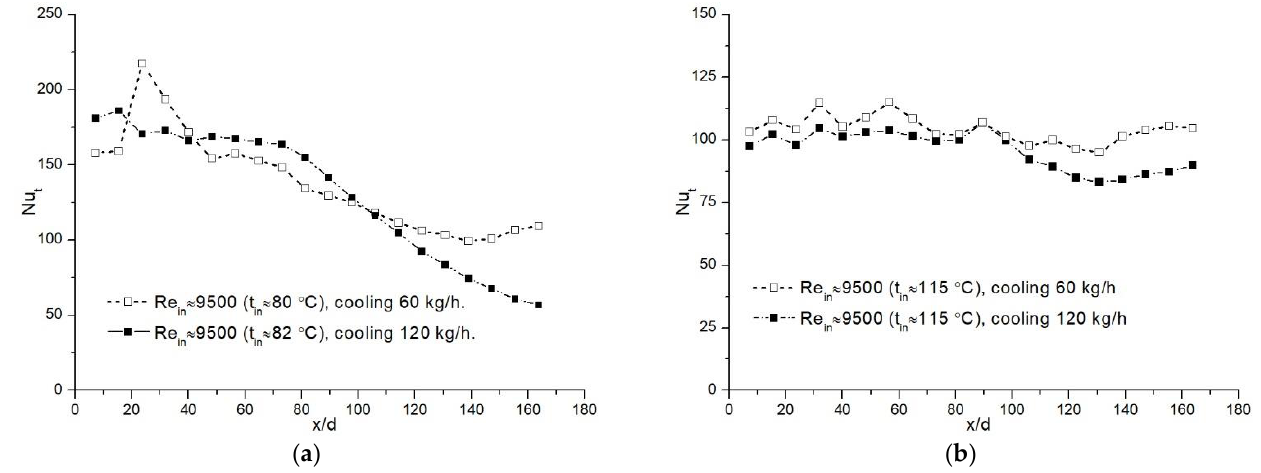
Figure 3. Variation of the Nu t along the heat exchanger at Re in ≈ 9500, different inlet temperatures (smaller ( a ), higher ( b )) as well as cooling water flow rates.